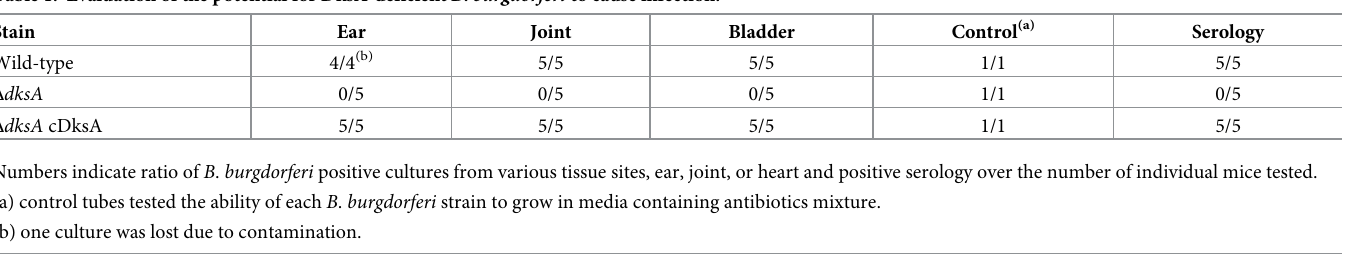
I . scapularis . To more robustly test the role of DksA in host and vector infection and coloniza- tion, we artificially infected I . scapularis larvae by submersion in liquid cultures containing wild-type, Δ dksA , or Δ dksA cDksA B . burgdorferi grown to a density of 5 x 10 7 spirochetes � ml -1 and tested the ability of the larvae to transmit the three strains to na ï ve mice. Approxi- mately 200 artificially infected larval stage ticks with the wild-type, Δ dksA , or Δ dksA cDksA strains were allowed to feed on mice. Spirochetes in larval ticks were quantified 3–5 days fol- lowing the larval bloodmeal by plating a subset of homogenized ticks on semi solid BSK media. An additional subset of ticks were analyzed following the molt of larvae to nymphs, roughly 6 weeks after feeding (S4 Fig). I . scapularis larvae and nymphs colonized by the Δ dksA or Δ dksA cDksA strains showed lower spirochete numbers compared to wild-type controls; however, statistical analysis by one-way ANOVA and multiple comparisons test indicated the differences in spirochete numbers were not statistically significant (ANOVA p -value = 0.270, Tukey’s multiple comparisons test of Δ dksA fed larvae vs. Δ dksA colonized nymphs, p - value > 0.999). Cohorts of 5–10 I . scapularis nymphs infected with the wild-type, Δ dksA , or Δ dksA cDksA strains fed upon a total of three mice per strain. Three weeks after the I . scapu- laris bloodmeal, mice were euthanized. The ear, joint, and bladder tissues dissected from euthanized mice were collected and submerged into BSK II media. Outgrowth was detected in the tissues collected from mice fed upon by nymphs infected with the wild-type and Δ dksA cDksA strains, but not the Δ dksA strain (Table 2). Seroconversion was only observed in blood collected from mice infected with wild-type and Δ dksA cDksA B . burgdorferi strains and col- lected tissues showed detectable B . burgdorferi outgrowth following culturing in BSKII media (S5 Fig). These data provide additional evidence DksA is either required for transmission from I . scapularis to the host or that the Δ dksA strain is readily cleared by the host immune system prior to the generation of a strong antibody response, similar to what is seen for mutants unable to synthesize OspC [70].